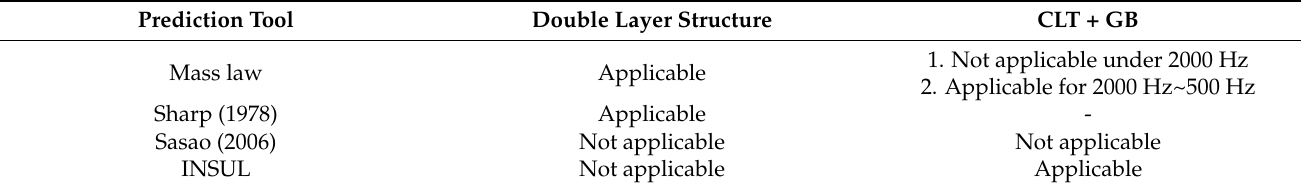
Figure 21. Comparison between experimental and predicted results of CLT + GB with 50 mm glass wool and twice the Gypsum board than in C4 (C5). ( a ) The sound insulation performance of experiment and prediction. ( b ) The RMSE results of different prediction models. Table 4. Analysis of applicable methods with the different prediction tools for the CLT wall structure.